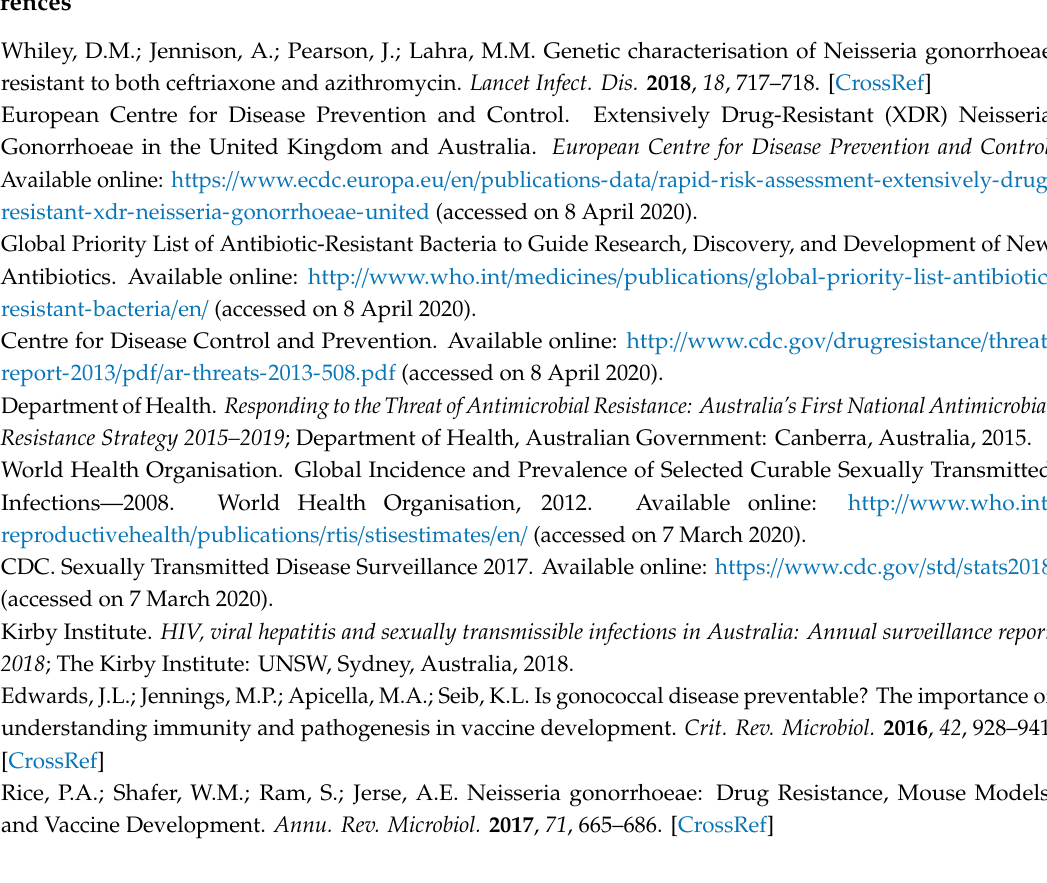
Figure S1: Survival of Neisseria gonorrhoeae in human serum, Figure S2: Expression of NHBA in N. gonorrhoeae , Figure S3: Immunogenicity of NHBA, Figure S4: Serum bactericidal activity (SBA) of anti-NHBA serum, Figure S5: Surface plasmon resonance (SPR) analysis of NHBA-heparin interactions, Table S1: Distribution of NHBA peptide variants in N. gonorrhoeae isolates that have an annotated NHBA protein in the PubMLST